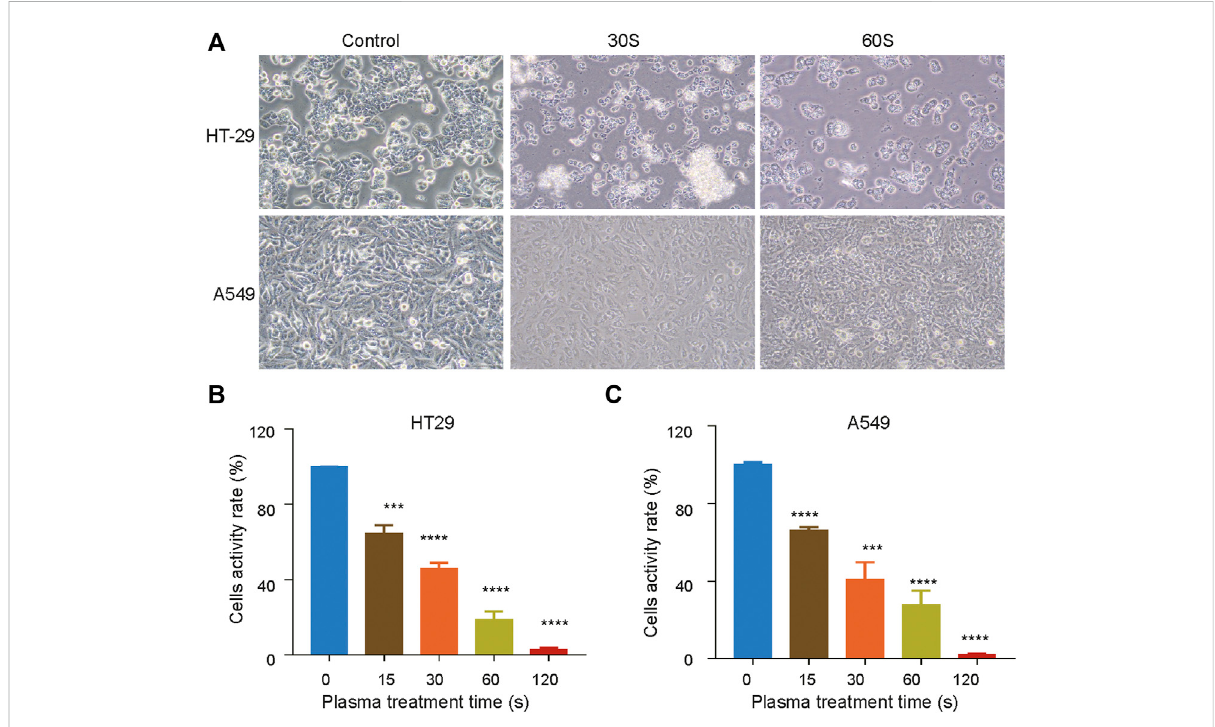
FIGURE 2 InhibitionofcellproliferationbyCAP PZ2 treatment. (A) OpticalimagesoftheHT29andA549cellulardamagecausedbyCAP PZ2 treatment. (B,C) Cell activity decreases while CAP PZ2 treatment duration increases. The above images and values represent results from three independent experiments and expressed as mean ± SD. * p < 0.05 was considered statistically signi fi